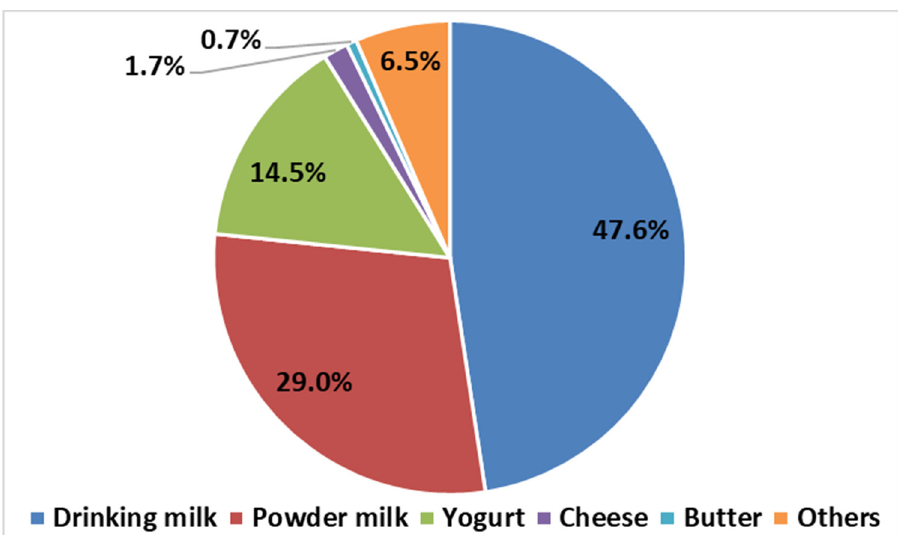
Figure 9. The turnover market shares of dairy products in 2020. Source: SSI [66].